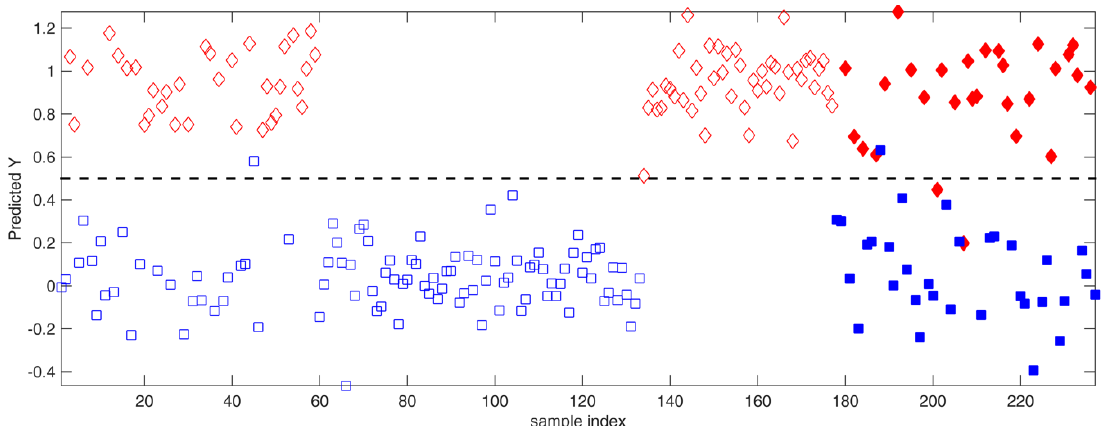
Figure 2. PLS-DA analysis: Predicted Y vs. sample index. Legend: Class Sorrento: Red diamonds; Class Non-Sorrento: Blue squares. The black dashed line represents the classification threshold between the two classes (Sorrento for y > threshold; Non-Sorrento for y < threshold). Empty and filled symbols represent training and test samples, respectively.